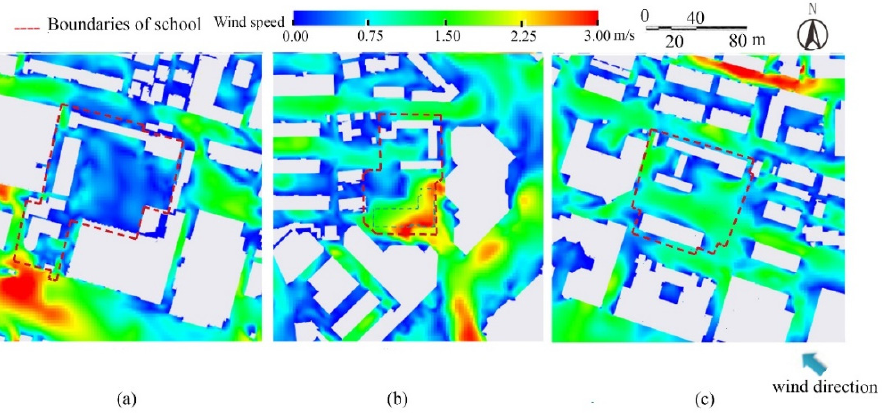
Figure 5. Wind speed distributions at the pedestrian level in three primary schools in summer in the 1990s: ( a ) Changjiang Road Primary School; ( b ) Chibi Road Primary School (Shanxi Road Cam- pus); ( c ) Jianye Road Primary School.